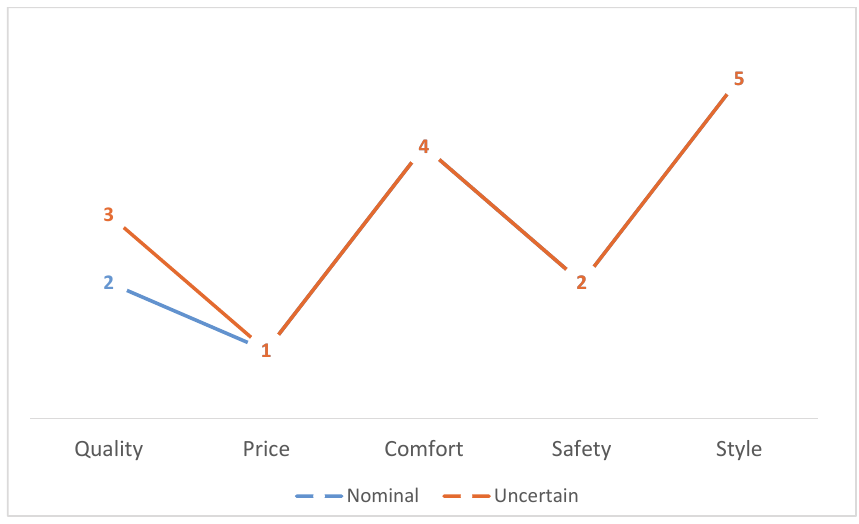
Fig 1. Compare of ranking of criteria in example